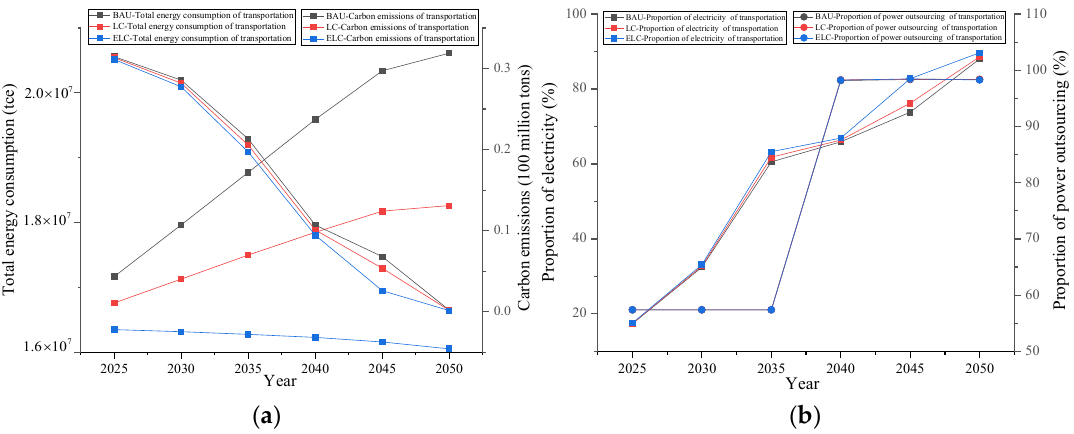
Figure 8. Analysis of the transportation sector: ( a ) total energy consumption and carbon emissions in the transportation sector; ( b ) proportion of power and external electricity in the transportation sector.